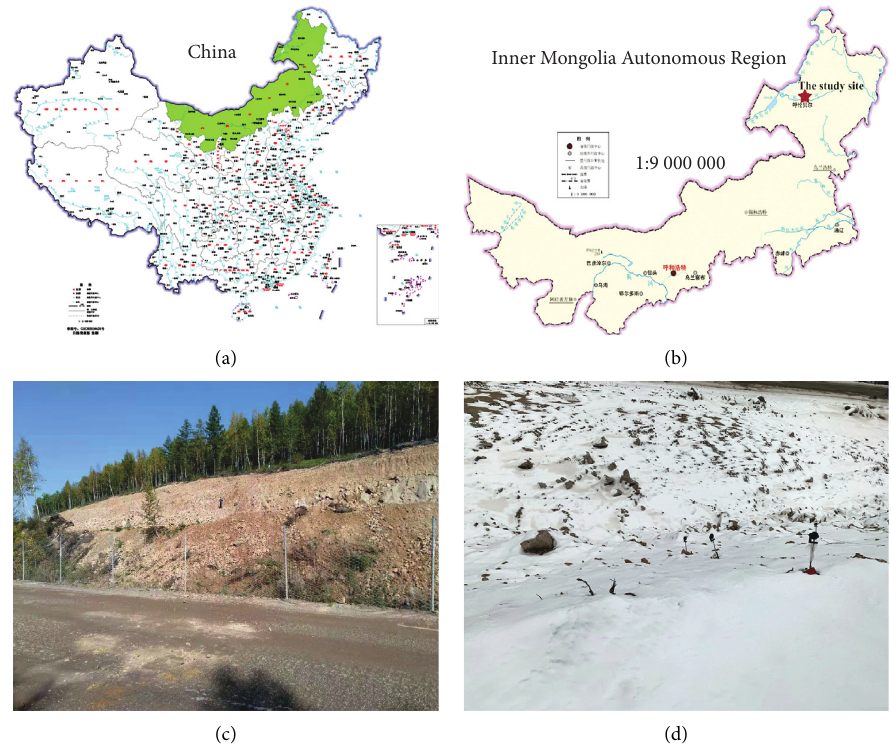
Figure 1: Geographic location of the study site. (a) The location of the study site in China; (b) the location of the study site in the permafrost region of the Greater Khingan Mountains in the Hulunbuir, Inner Mongolia Autonomous Region; (c) the landscape of the field monitoring site; and (d) the cutting slope covered by a large amount of snow in winter.